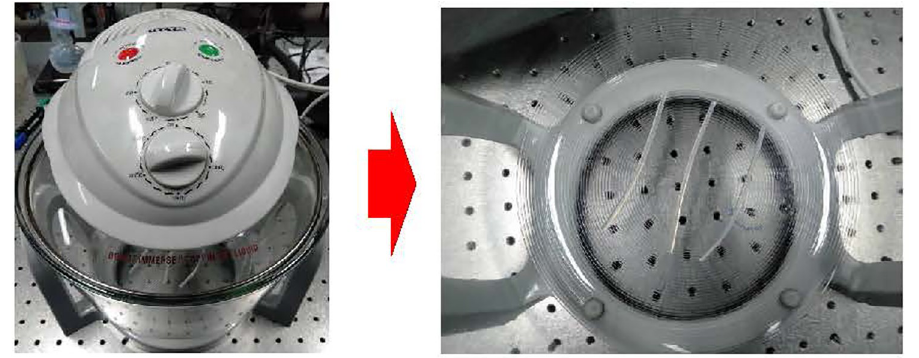
Fig 9. Dry heat at 75˚C for 5 min for 5, 10, 30 and 60 cycles.